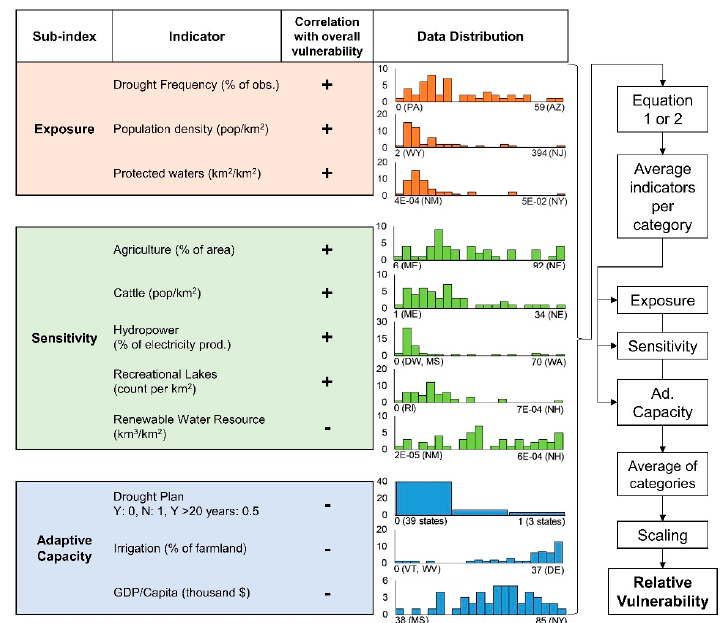
Figure 1. The indicators used in the analysis, grouped into their respective sub-indices, Exposure, Sensitivity, and Adaptive Capacity. The correlation sign with the overall relative vulnerability is